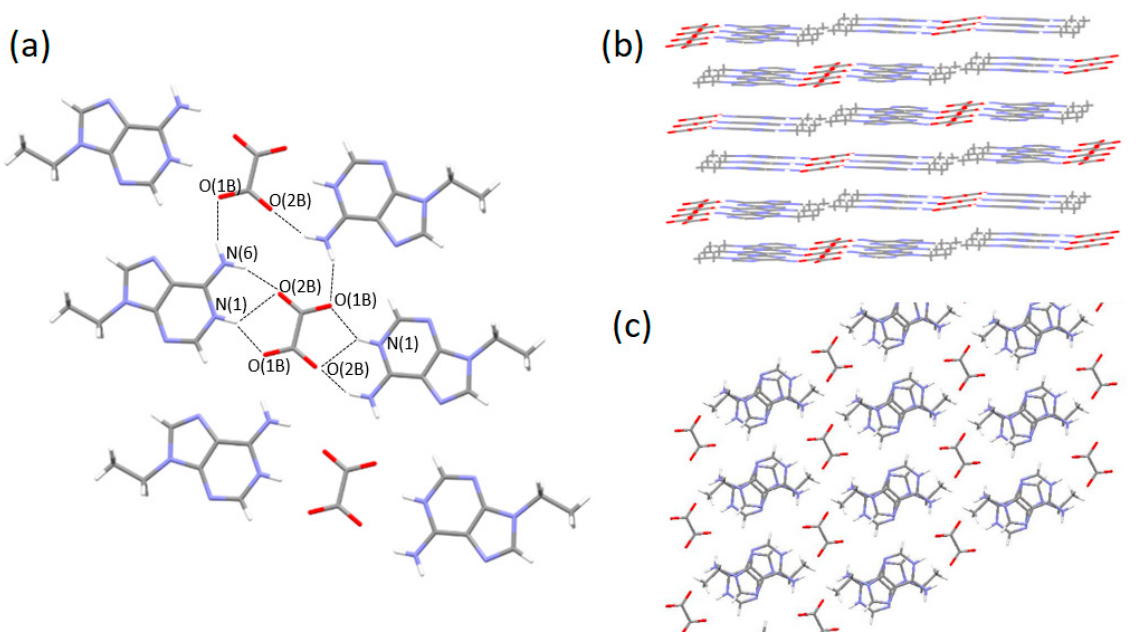
Figure 4. ( a ) Hydrogen bonds and ( b ) packing of the belts (view along the b axis, slightly tilted to improve the perspective) and ( c ) π – π stacking (view along the c axis) in 9ETADE-oxalic acid (2:1) salt ( 3